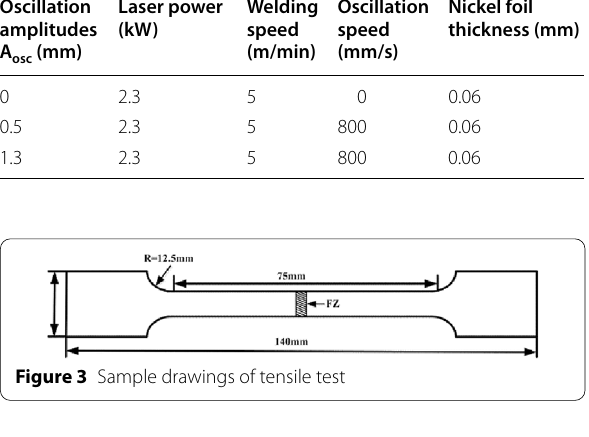
, c top surface for = 0.5